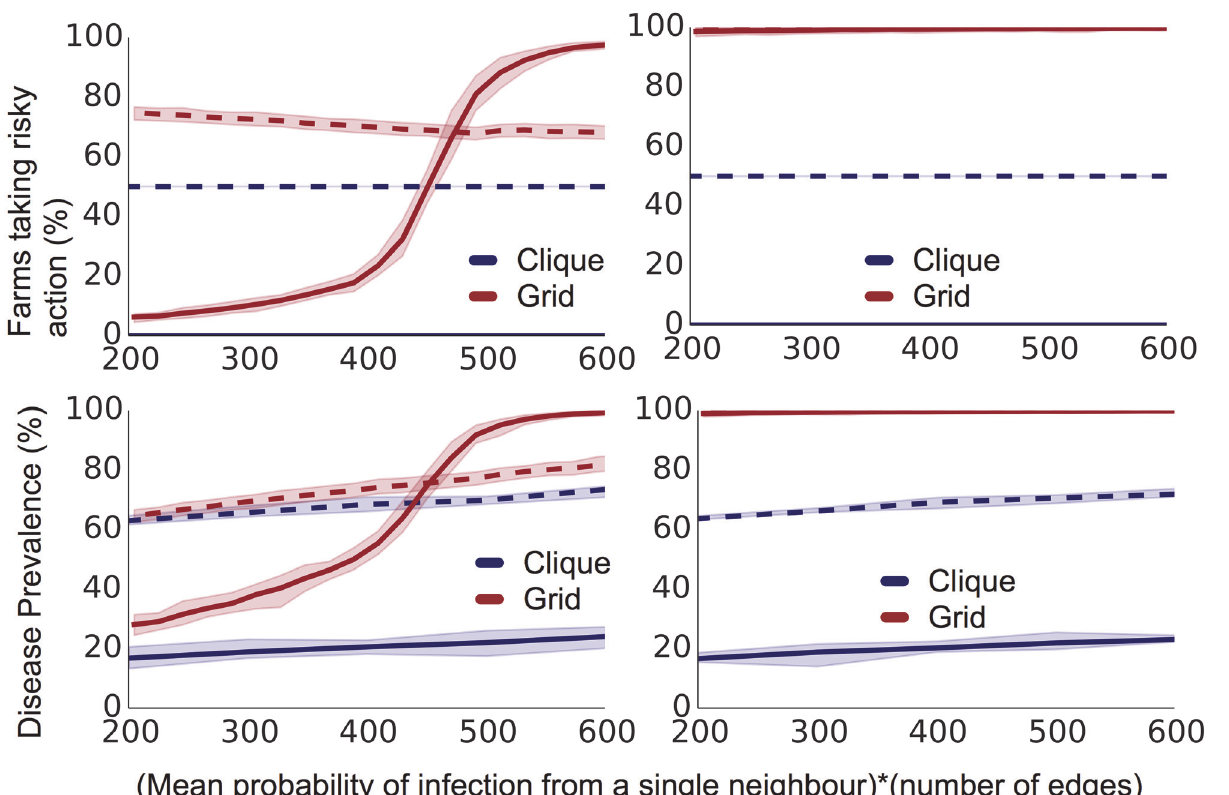
Fig 1. Disease and risky action prevalence after 100 time steps of simulation on a grid graph and a clique graph with bimodal and unimodal distributions of payoffs over a variety of neighbourhood infectiousnesses. In the left column we show results for idealist farms which compare their payoffs to a set general payoff estimate, and on the right realist farms that compare to past payoffs they have experienced. In the top row we show the percentage of farms that are taking the risky action, and in the bottom row the disease prevalence The simulations with unimodal payoff distributions are shown with solid lines, and ones with bimodal distributions in dotted lines. The dotted and solid red lines on the right are identical. Results from simulations on cliques are shown in blue, and results from simulations on grids in red. 95% confidence envelopes are plotted in pale shading around each